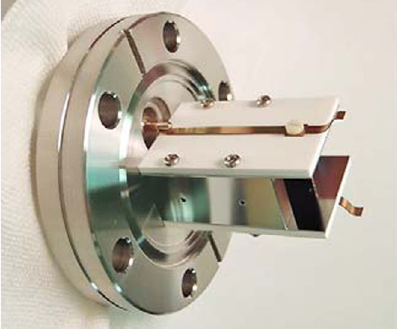
FIG. 14. Photograph of a signal transmission line with the microstripline structure.